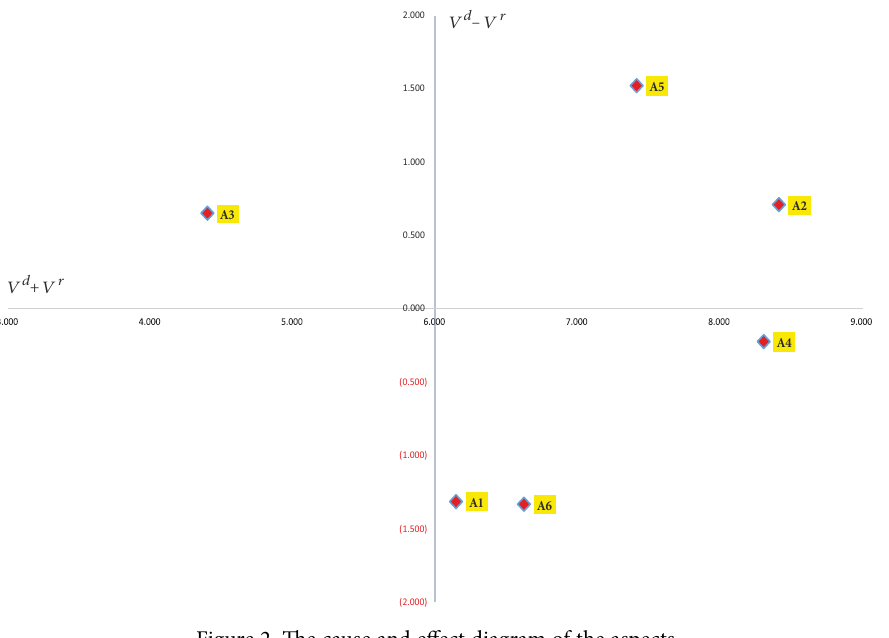
Figure 2. The cause and effect diagram of the aspects